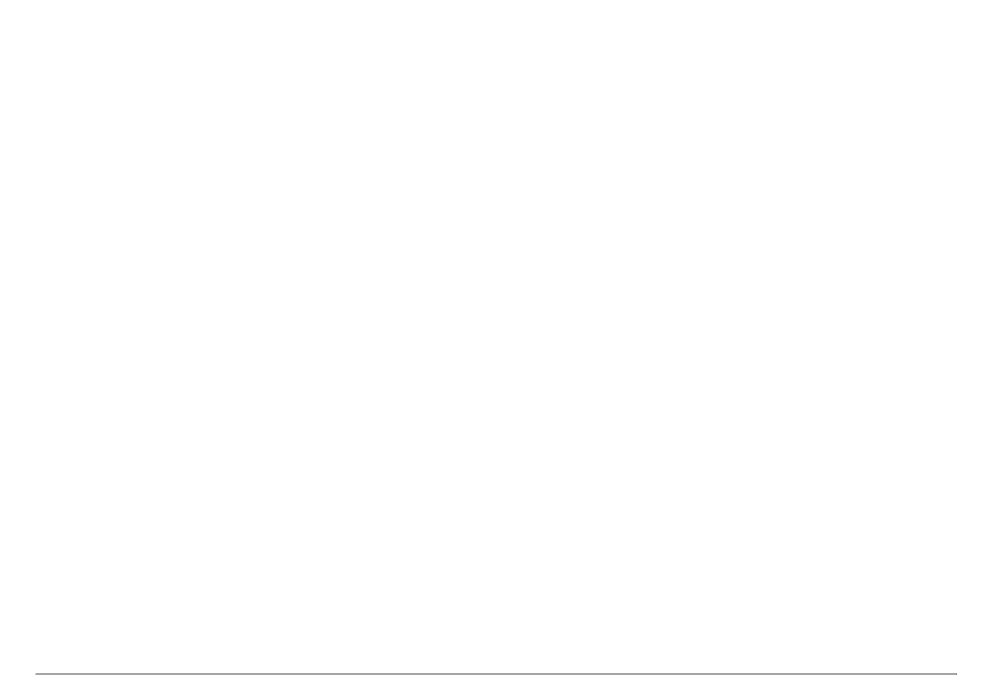
Raoul Walsh, between the Western and the Southern: Pursued (1947), Silver